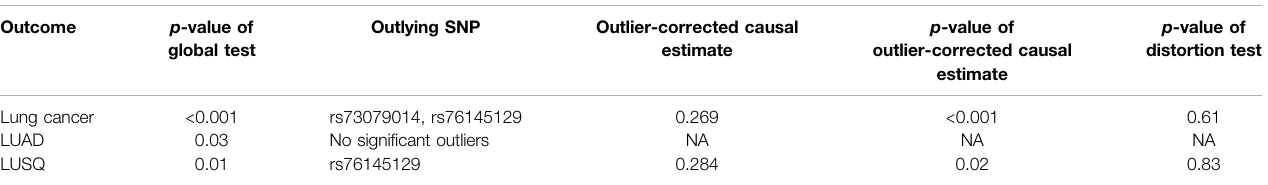
TABLE 5 | Results of MR PRESSO for the estimation of horizontal pleiotropy. Outcome p -value of Outlying SNP Outlier-corrected causal global test